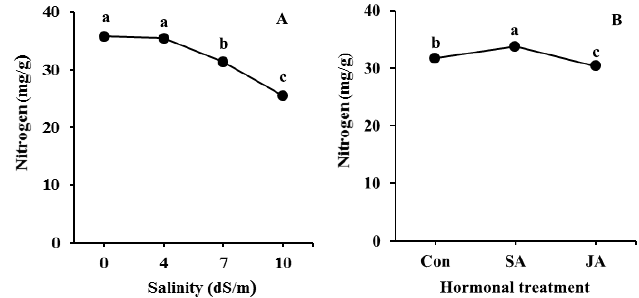
Fig. 1: Changes in nitrogen content of soybean leaves under different sa- linity (A) and hormonal treatments (B) Different letters indicate significant difference at p ≤ 0.05.